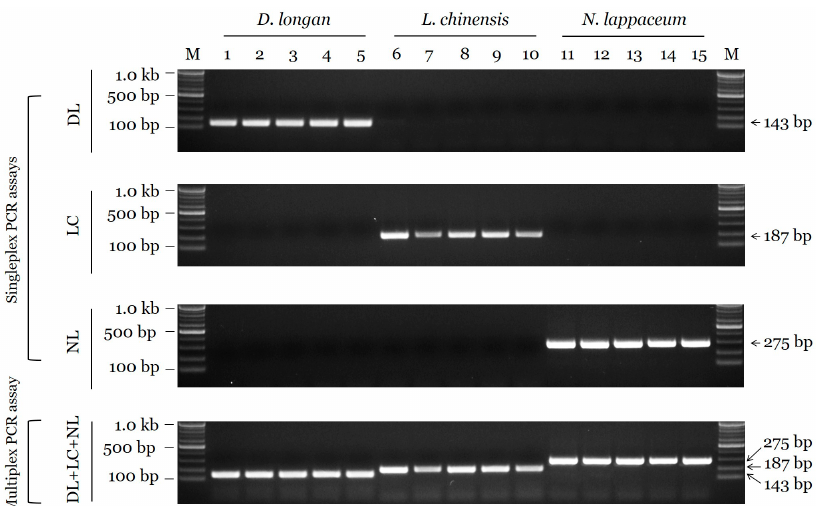
Figure 2. Specificity of singleplex and multiplex PCR assays for D. longan , L. chinensis , and L. lappaceum . M: 100 bp DNA size marker (100–1000 bp), Lanes 1–5: D. longan , Lanes 6–10: L. chinensis , Lanes 11–15: N. lappaceum . DL, LC, and NL indicate the primer sets. Arrowheads indicate the amplified fragment sizes.